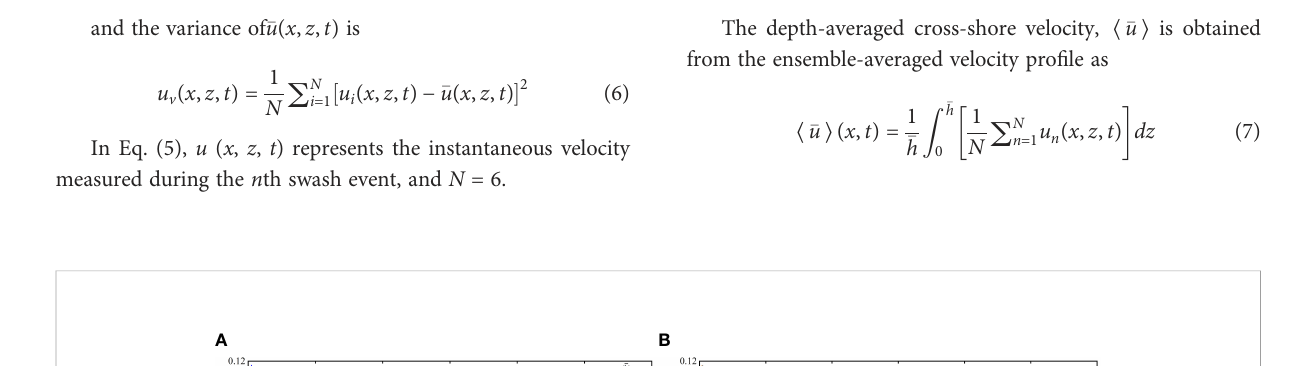
and the variance of (cid:1) u ( x , z , t ) is